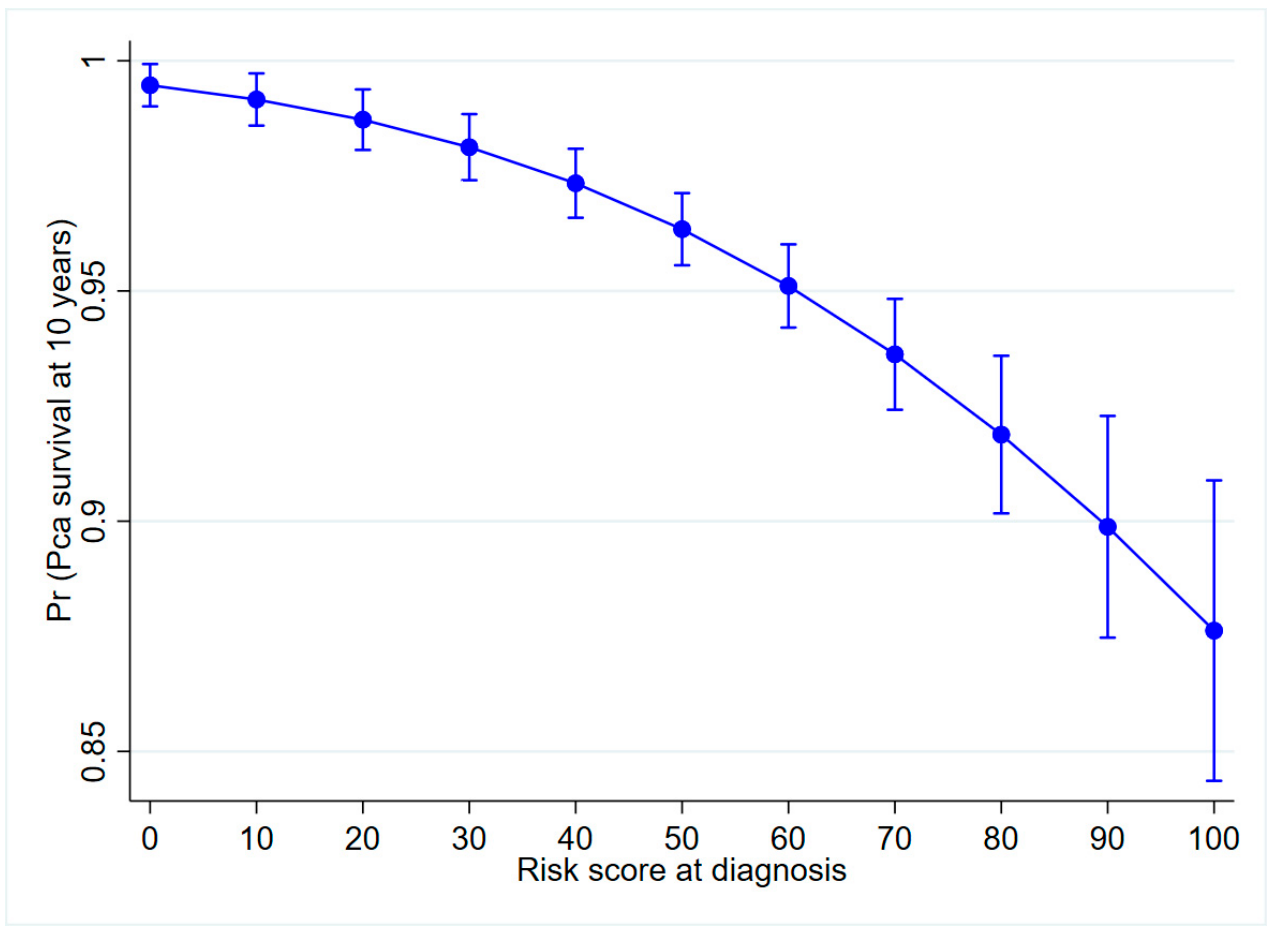
Figure 3. Predicted probability of PCa survival at 10 years from diagnosis among controls in the Finnish randomized screening trial.